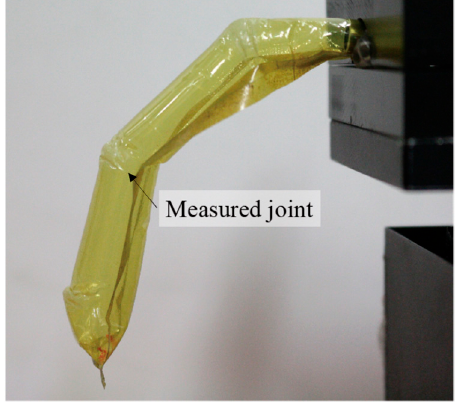
Figure 15. Bending deformation of the pod structure actuator.